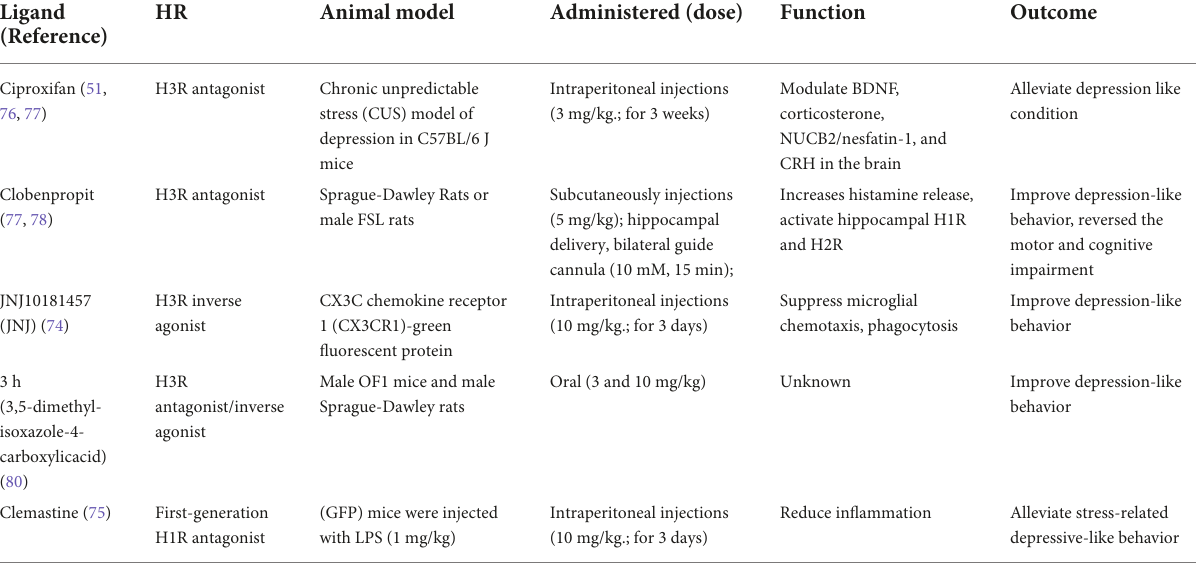
TABLE 2 Therapeutic prospect with histamine receptor for